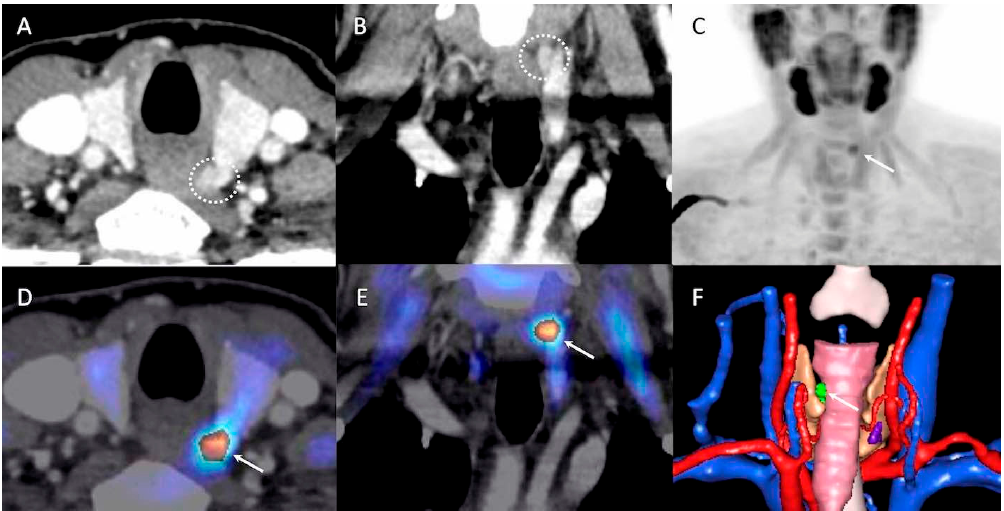
Figure 3. 52-year-old woman with recurrent primary hyperparathyroidism (pHPT) and previous history of surgical ablation of left inferior parathyroid adenoma. First-line imaging was negative. Preoperative positron emission tomography/four-dimensional computed tomography (PET/4D-CT) showed increased focal 18 F-FCH uptake (arrow) corresponding to 1 cm nodule located behind the superior pole of left thyroid lobe (left upper quadrant), with a typical contrast media enhancement (dotted circle). Parathyroid adenoma (0.1 g, 9 mm) was confirmed by pathology. ( A , B ): four-dimensional computed tomography 4D-CT, axial and coronal slices; ( C ): 18 F-Fluorocholine positron emission tomography 18 F-FCH PET, anterior maximum intensity projection (MIP); ( D , E ): PET / 4D-CT, axial and coronal slices; ( F ): 3D-virtual neck exploration, posterior view; green: left upper parathyroid, rose: esophagus, orange: thyroid.